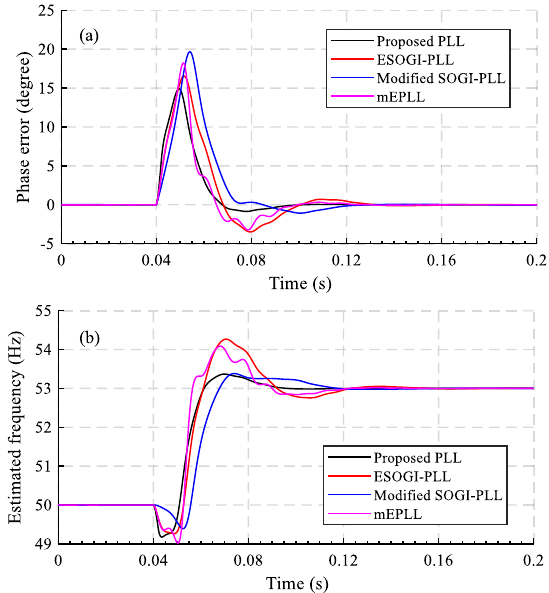
Fig. 10 Performance comparison between the proposed PLL, ESOGI-PLL, modified SOGI-PLL, and mEPLL under Case 4 (a frequency jump of 3 Hz and a DC offset of 0.15 pu added to the grid voltage at 0.04 s). a Estimated phase error and b estimated grid